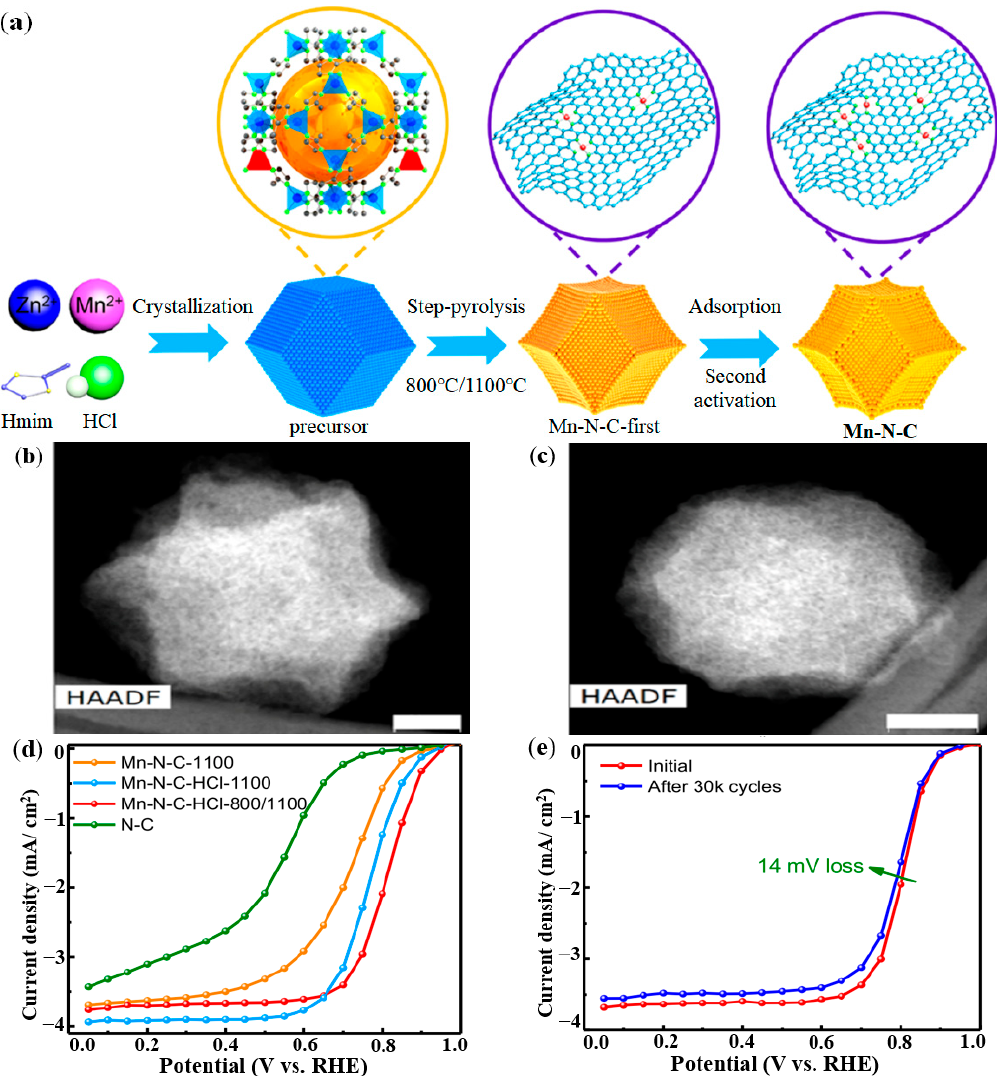
Figure 8. Synthesis method and performance of Mn-N-C catalyst: ( a ) Synthesis strategy of Mn-N-C catalyst; ( b ) HAADF-STEM image of Mn-N-C-HCl-800/1100-first catalyst; ( c ) HAADF-STEM image of Mn-N-C-HCl-800/1100 catalyst; ( d ) ORR activity; ( e ) ORR durability. Adapted with permission from Ref. [98]. Copyright 2020 American Chemical Society.